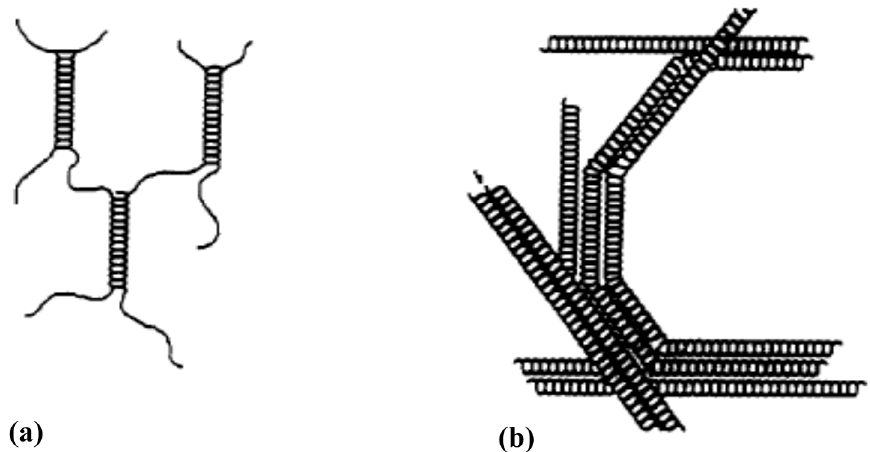
Figure 1. Schematic representations of possible mechanisms of network formation in helical gels: gelation on: ( a ) the helical level; and ( b ) super-helical level. Reproduced from [68] with permission. Copyright 1994 American Chemical Society.